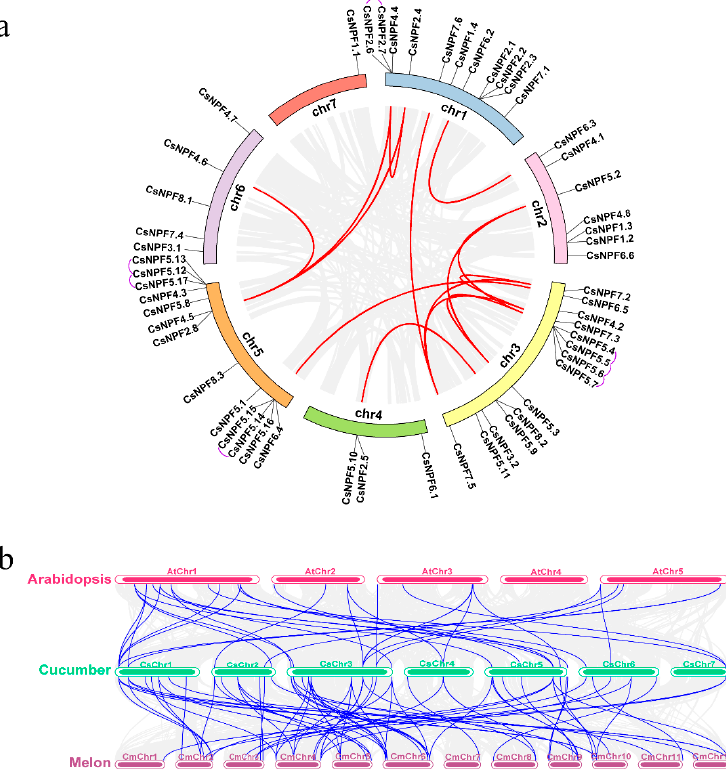
Figure 5. Chromosomal distribution, gene duplication, and synteny analysis of CsNPF genes. ( a ) Schematic representations of the chromosomal distribution and interchromosomal relationships of CsNPF genes. Gray lines in the background indicate all syntenic blocks in the cucumber genome, red lines indicate segmental duplication gene pairs, and purple lines in the outer ring indicate tandem duplication gene pairs. ( b ) Synteny analysis of NPF genes between cucumber and Arabidopsis and melon. The gray lines indicate all collinear blocks, and the blue lines indicate collinear NPF gene pairs.